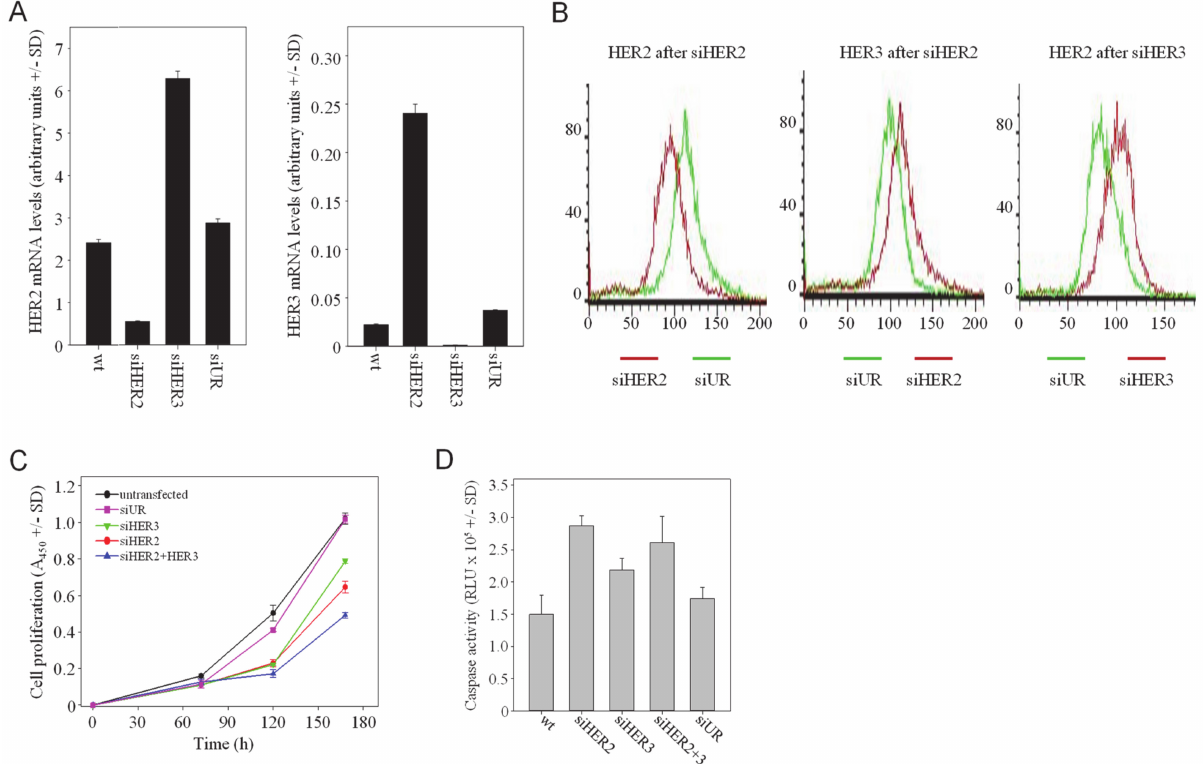
Figure 1. HER single knockdown leads to the counter-upregulation of the respective other HER family member, and combined HER2/HER3 knockdown leads to enhanced antitumor effects. ( A ) SKOV3 cells were transfected with siRNAs as indicated in the figures and analyzed for mRNA levels of HER2 (left) and HER3 (right). ( B ) Alterations of HER2 and HER3 protein levels, as determined by flow cytometry. ( C ) Anti-proliferative and ( D ) pro-apoptotic effects upon siRNA-mediated single or double knockdown of HER2 and/or